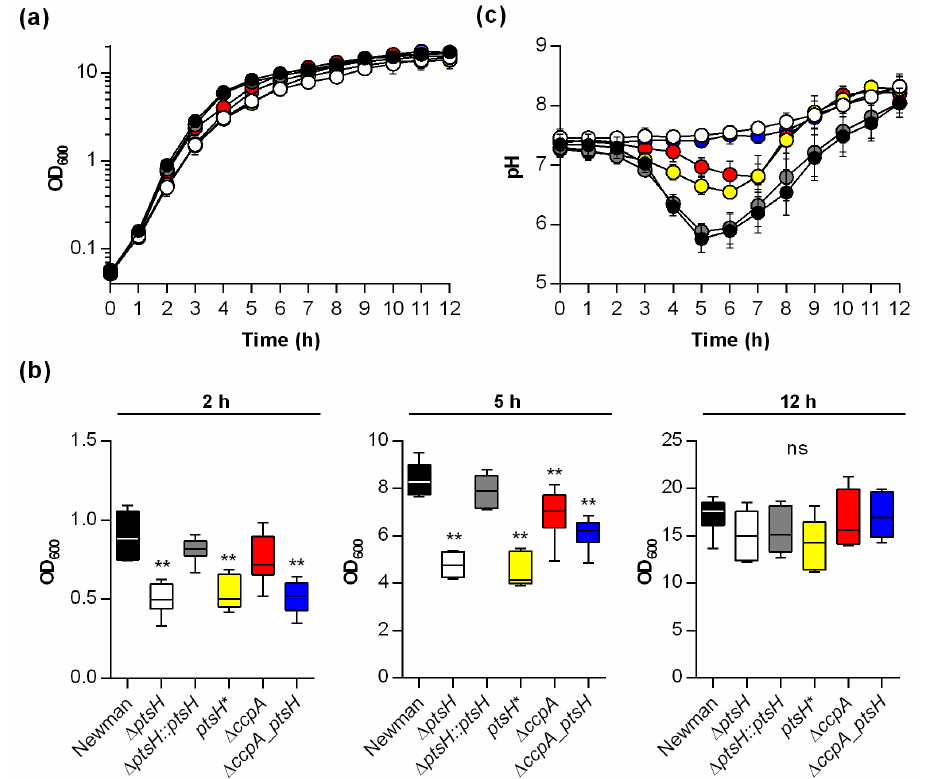
Figure 1. Impact of ptsH and/or ccpA on growth and pH profiles of S. aureus TSB cultures. Bacteria were inoculated to an OD 600 of 0.05 in TSB and cultured aerobically at 37 ◦ C and 225 rpm. OD 600 ( a , b ) and pH measurements ( c ) of the culture media were determined hourly. Symbols represent: strains Newman (black symbols), Nm ptsH (white symbols), Nm ptsH::ptsH (grey symbols), Nm ptsH * (yellow symbols), Nm ccpA (red symbols), and Nm ccpA_ptsH (blue symbols). The results are the mean ± SD of at least five independent experiments. ( b ) OD 600 readings of the cell cultures at 2, 5, and 12 h of growth, respectively. The data are presented as box and whisker plot showing the interquartile range (25–75%, box), the median (horizontal line), and the standard deviation (bars) of 5–6 independent experiments. **, p < 0.01 (one-way ANOVA and Holm-Sidak’s multiple comparison test. Only differences between Newman and mutants are shown). Table 2. Generation time of S. aureus strains cultivated in TSB under aerobic conditions.